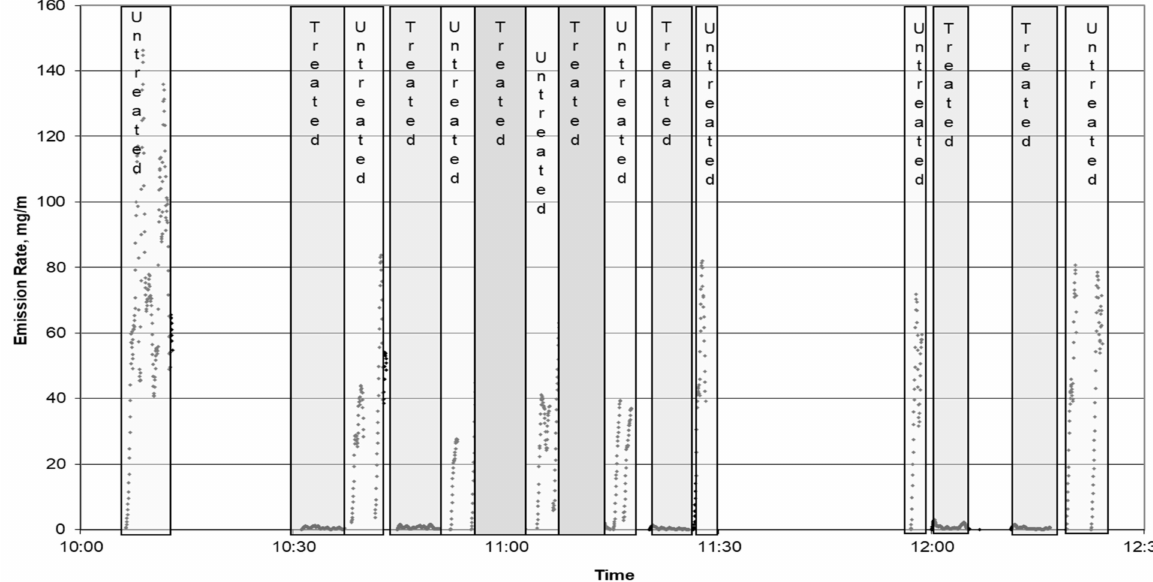
Figure 5. Time series plot of PM 10 emissions during the test on